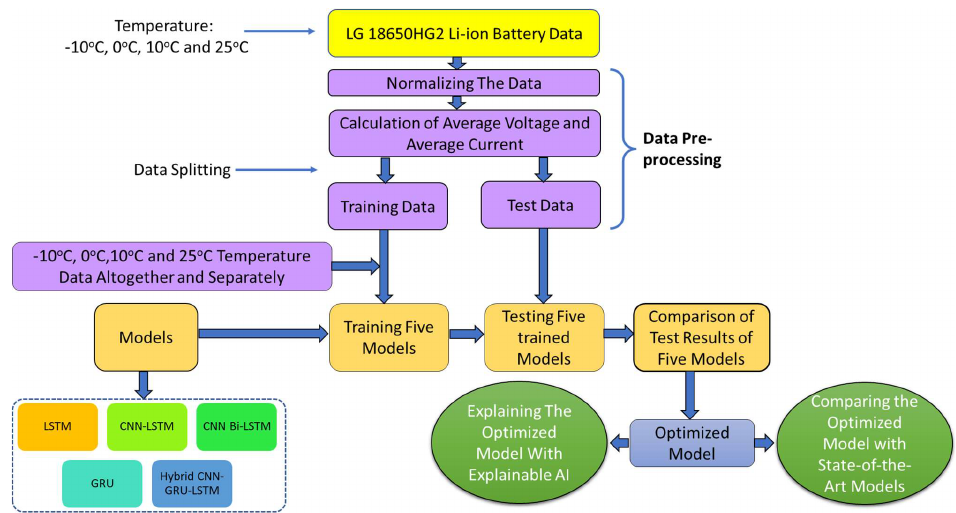
Figure 2. Overall design of the study for the SOC estimation of the EV battery.